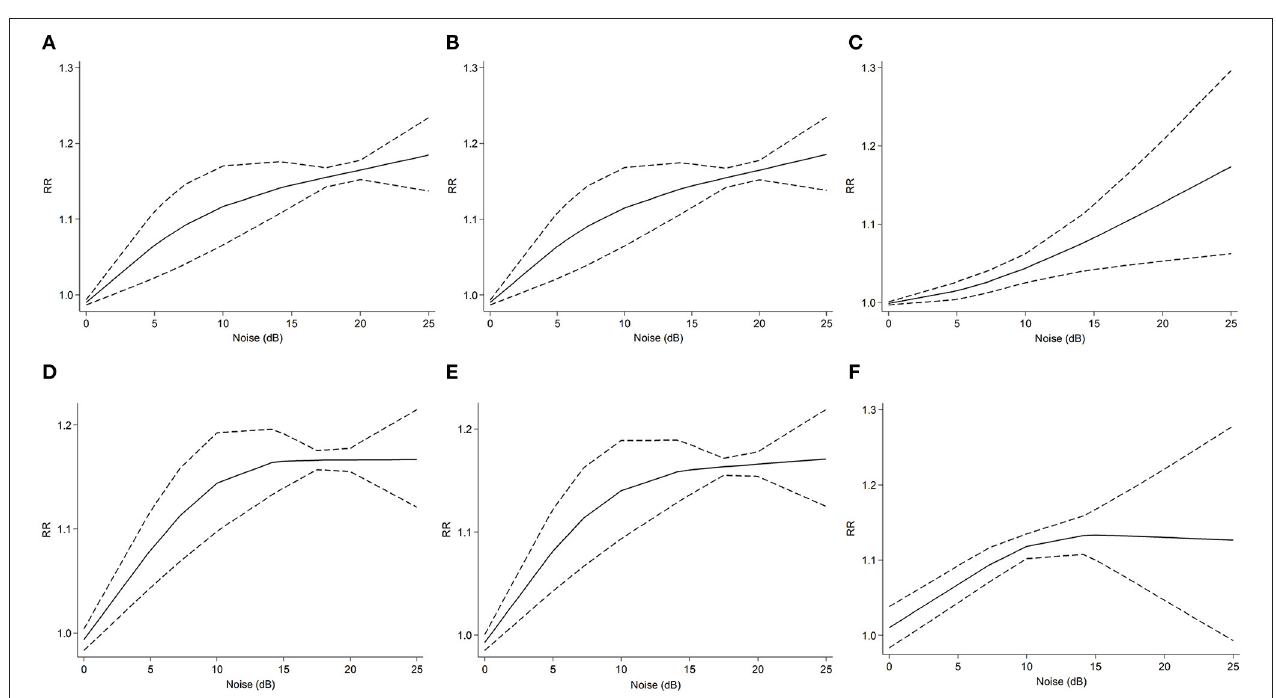
FIGURE 2 | Dose-response meta-analysis between noise exposure and risk of all kinds of dementia. The horizontal axis represents the noise increment, and the vertical axis represents the relative risk of noise increase to dementia. The two dashed lines represent the upper and lower limits of the 95% confidence interval for relative risk. (A) dose-response analysis of all studies. (B) dose-response analysis of cohort studies.